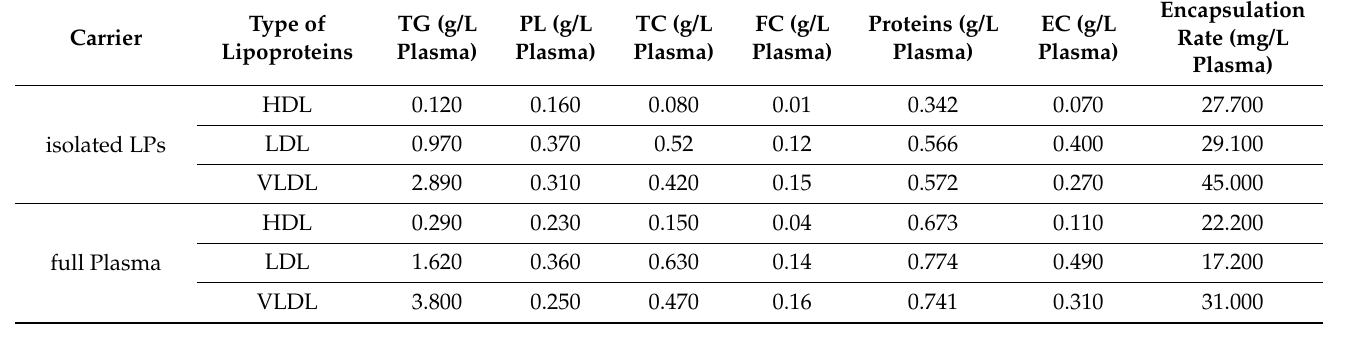
Table 3. Difference in the association rate of cyclosporine with the different types of lipoproteins before and after separation from the plasma.